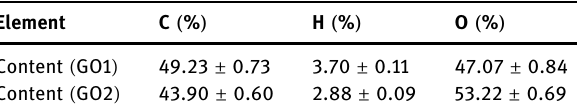
Table 1: Elemental analysis of two di ff erent GOs